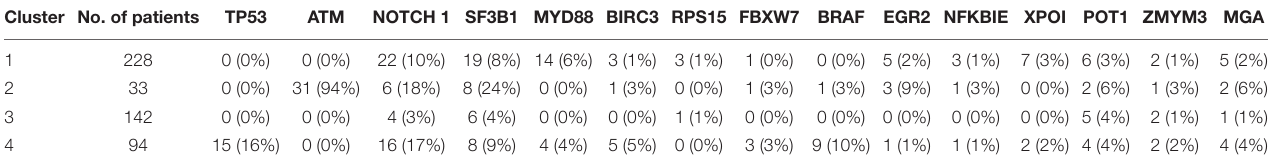
TABLE 2 | Distribution of common CLL driver genes among the identified clusters. Cluster No. of patients